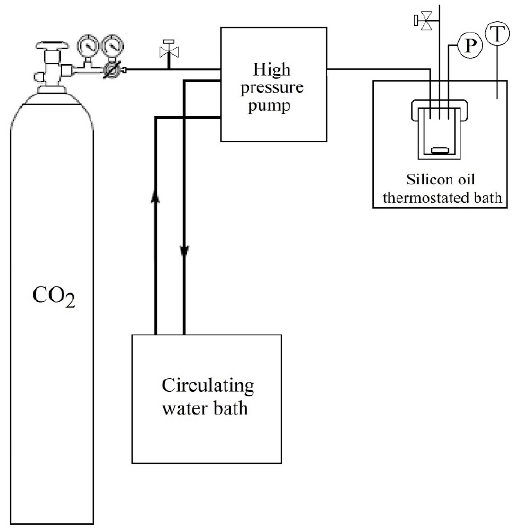
Figure 2. Schematic representation of the supercritical CO 2 impregnation system.